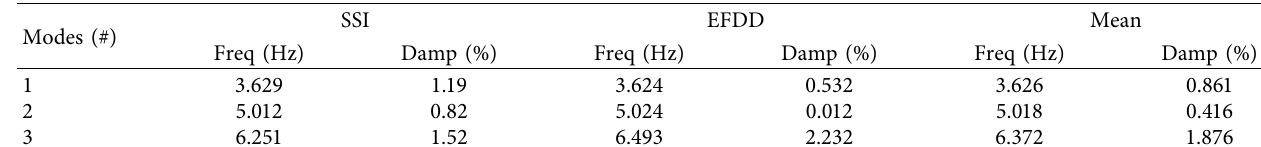
Figure 6: Experimental frequencies and vibration modes. (a) First-order transverse bending, f � 3.626Hz, and damp � 0.861%. (b) Second- 1 order left and right torsion, f 2 � 5.018Hz, and damp � 0.416%. (c) Third-order vertical bending, f 3 � 6.372Hz, and damp � 1.876%. Table 1: The frequencies and damping for the research.